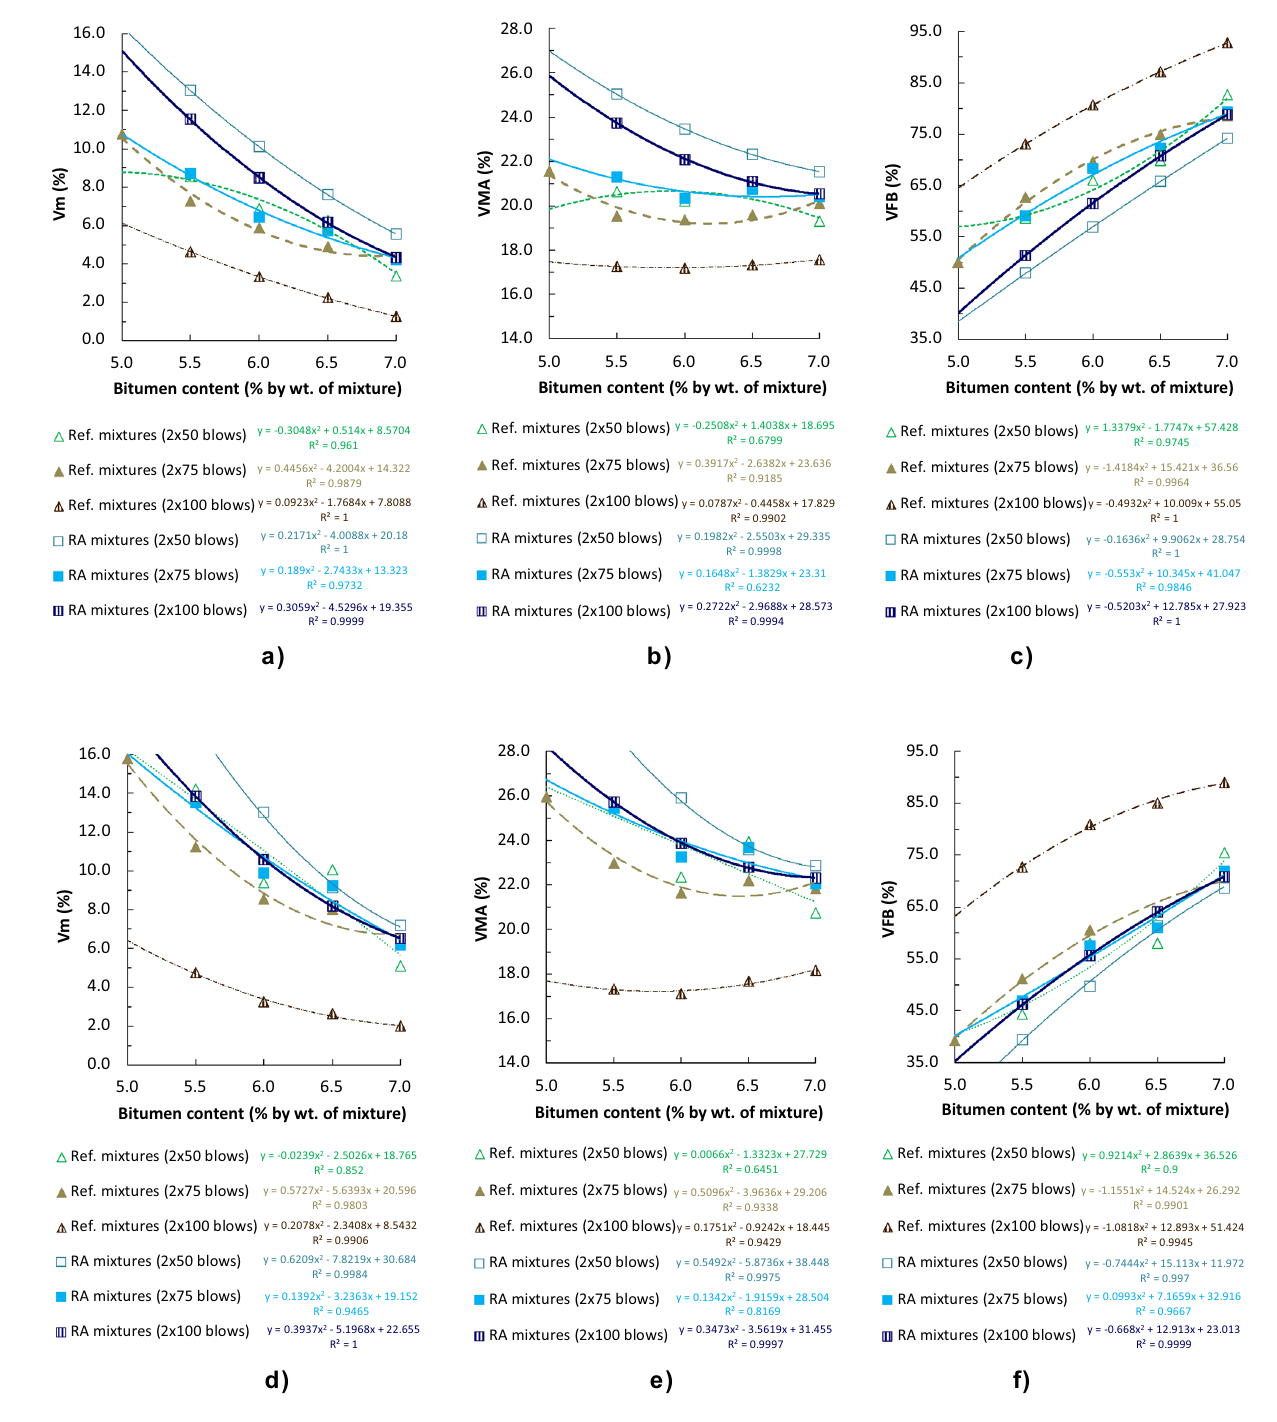
Figure 4. Void characteristics of cylindrical specimens with different compaction energies (EN 12697-8) [( a )– ( c ) obtained by SSD bulk density; ( d )–( f ) obtained by geometric bulk